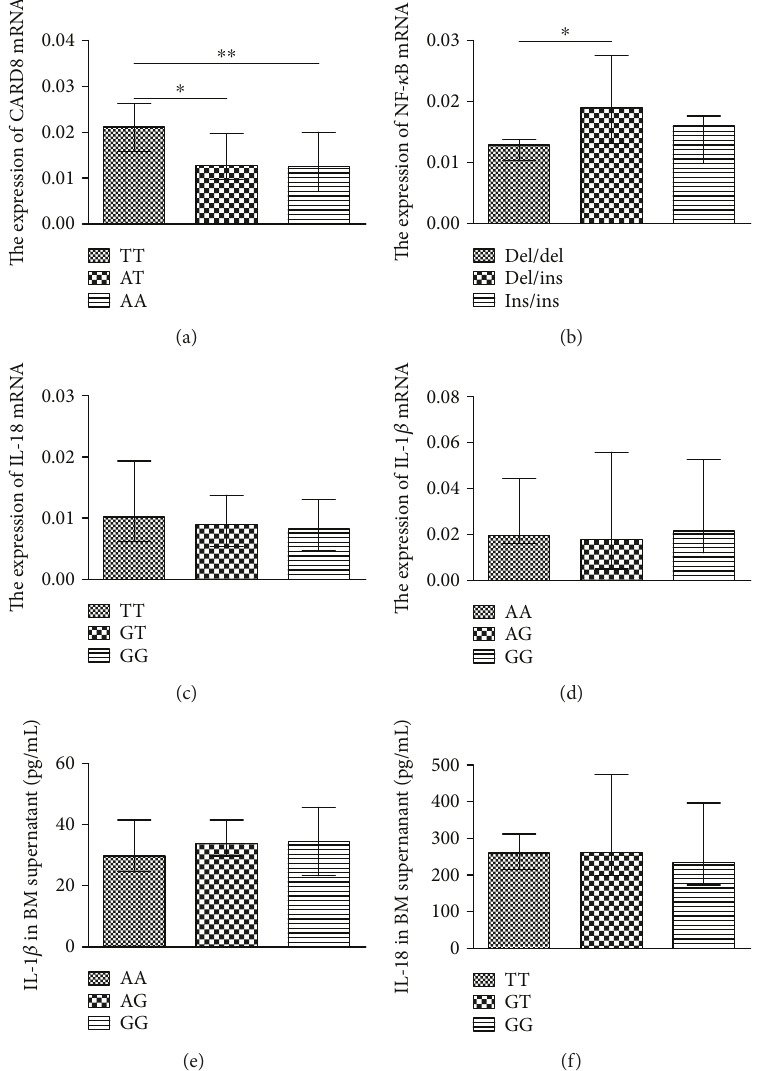
Figure 2: The expression of NLRP3 in fl ammasome-related genes was associated with the genetic polymorphisms in MM patients. (a) The relative expression of CARD8 mRNA in the genotype of the rs2043211 in MM patients. (b) The relative expression of NF- κ B mRNA in NF- κ B polymorphisms. (c-d) The association between the genetic polymorphisms of rs1946518 (c) or rs16944 (d) with their relative mRNA expression in MM patients. (e-f) IL-1 β in the three genotypes of rs16944 (e) and IL-18 in the three genotypes of rs1946518 (f) in the BM supernatant. ∗ P < 0 05 and ∗∗ P < 0 01